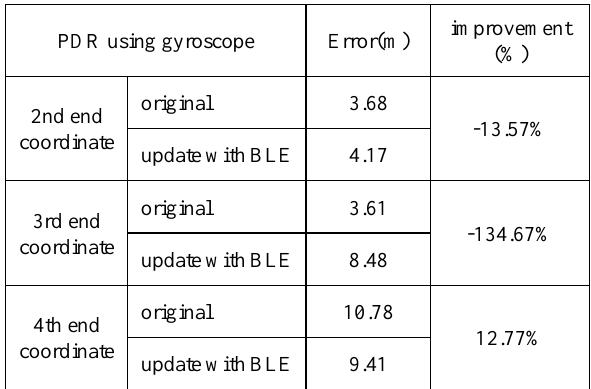
Table 4. The error of PDR using gyroscope of participant 1 Figure 10 is the trajectory of participant 2, while Table 5 and